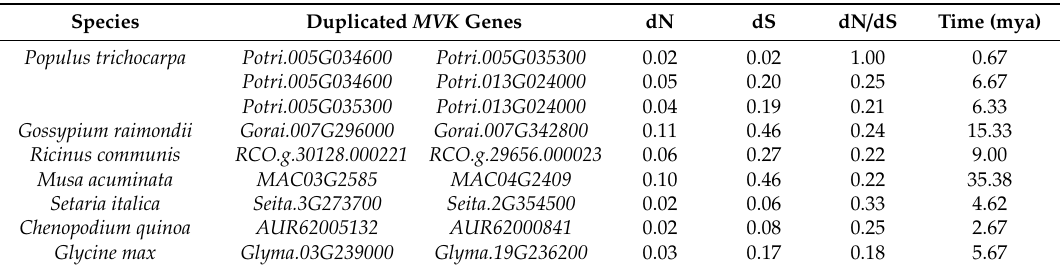
Table 4. Duplication time estimated by dN / dS analysis in MVK genes of seven plant species. Species